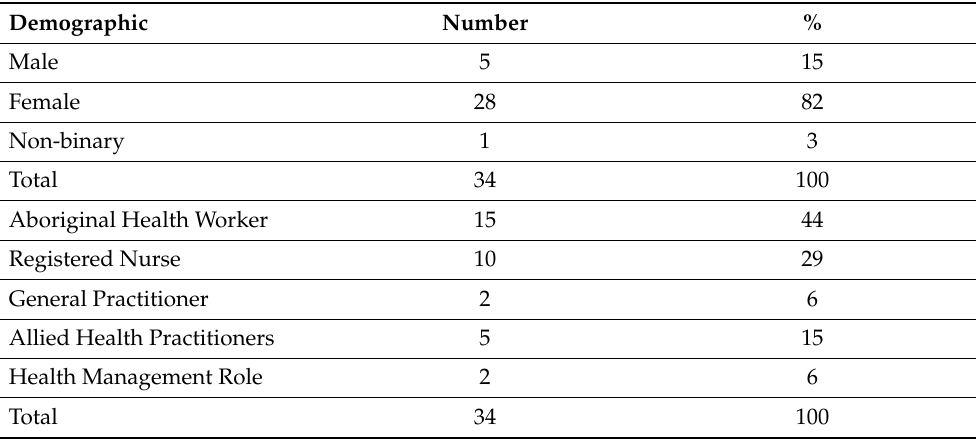
Table 2. Participants of the qualitative research (n =